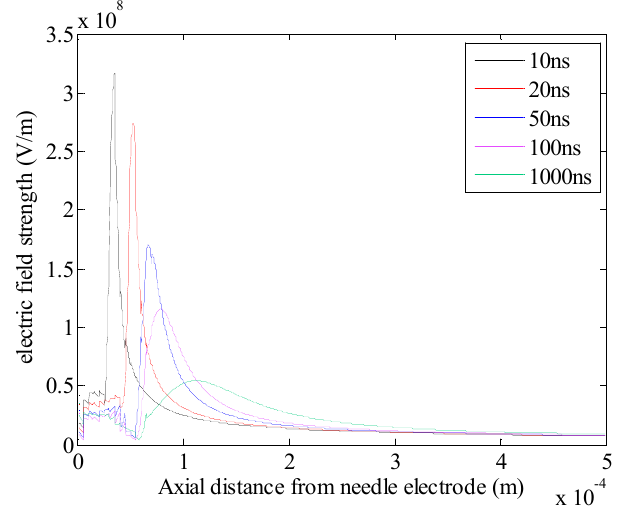
Figure 5. Electric field distribution along the needle-sphere axis as a response to 1.2 PDIV with 10 mm needle-sphere electrode